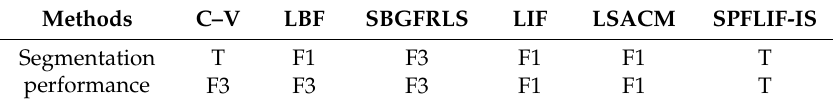
Figure 5. The segmentation results obtained for a texture image using the six models. ( a ) Original image, ( b ) C–V model, ( c ) LBF model, ( d ) SBGFRLS model, ( e ) LIF model, ( f ) LSACM model, and ( g ) SPFLIF-IS model. Table 4. Description of the segmentation results of Figure 5.